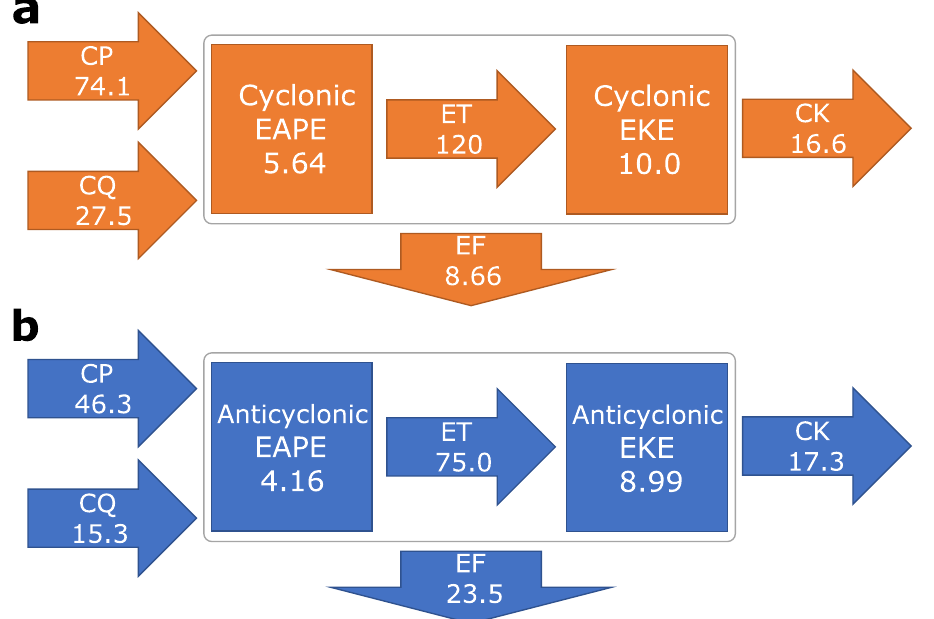
Figure 4. The Lorenz energetics separated into cyclonic and anticyclonic contributions. a-b , Climatological- mean energy budget averaged over the midwinter (24Jan) North Pacific [130° − 130°W, 20° − 65°N] for cyclonic ( a ) and anticyclonic ( b ) vortices. CK denotes the barotropic energy conversion (or KE conversion) into the background flow, CP the baroclinic energy conversion (or APE conversion) from the background flow, CQ the APE generation through diabatic processes, ET energy transfer from EAPE to EKE, and EF the energy inflow or outflow by energy fluxes through lateral boundaries of the domain. EAPE and EKE are in unit of EJ (= 10 18 J), while CK, CP, ET and EF in unit of TW (= 10 12 W). All the terms are integrated vertically from the surface to 100-hPa. The figure was created with Inkscape v1.0.1 (https:// www. inksc ape.